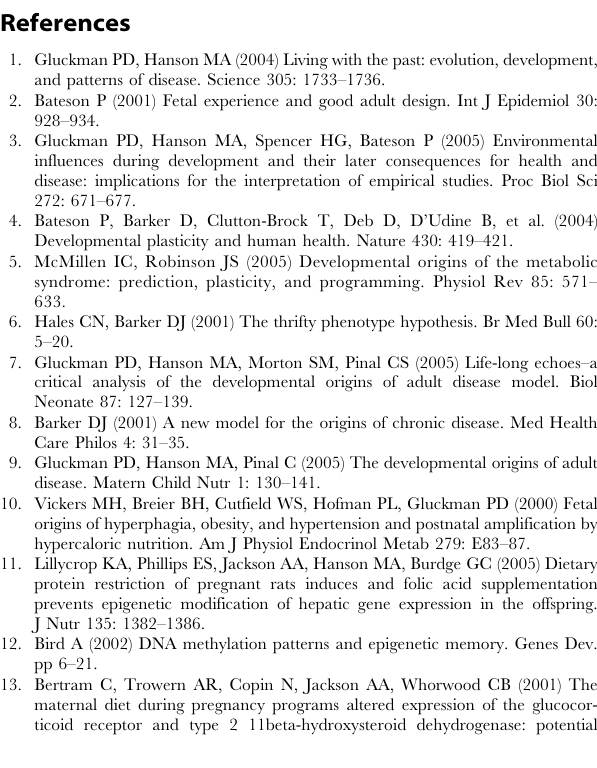
Figure S1 Illumina internal quality control measurements with BeadStudio Software for all 48 arrays. (A) Arrays should have signal intensities in the same range. There are three categories of signal intensity: low, medium, and high. A linear increase from low to medium to high is expected. (B) This image shows the individual medium intensity values for each array. Arrays should have signal intensities in the same range. (C) Compares the signal intensity of two mismatches to the signal intensity of a perfect match. The perfect matches should have a 3–4 fold higher signal. No signal intensite would indicate a hybridization failed. (D) Shows the high stringency of the data The biotin signal should be 3–4 fold lower than the high stringency signal. (E) This image shows the data for the negative control. The background signal should be approx- imately 70. The noise signal should be very low for high quality data. (F) This image compares the signal from the housekeeping genes to the signal from all genes. As housekeeping genes are always expressed they should have a much higher signal compared to all genes. Figure S2 Visualization of Raw and Normalized Microarray Data. Graphs are shown of raw data (A, B) and normalized (C, D) data for each of the 64 microarrays. (A)Boxplot of the amplitude for the array signal for the raw data. (B) Density plot of the intensity of the raw data for each array. (C) Boxplot of the amplitude for the array signal for the normalized data. (C) Density plot of the intensity of the normalized data for each